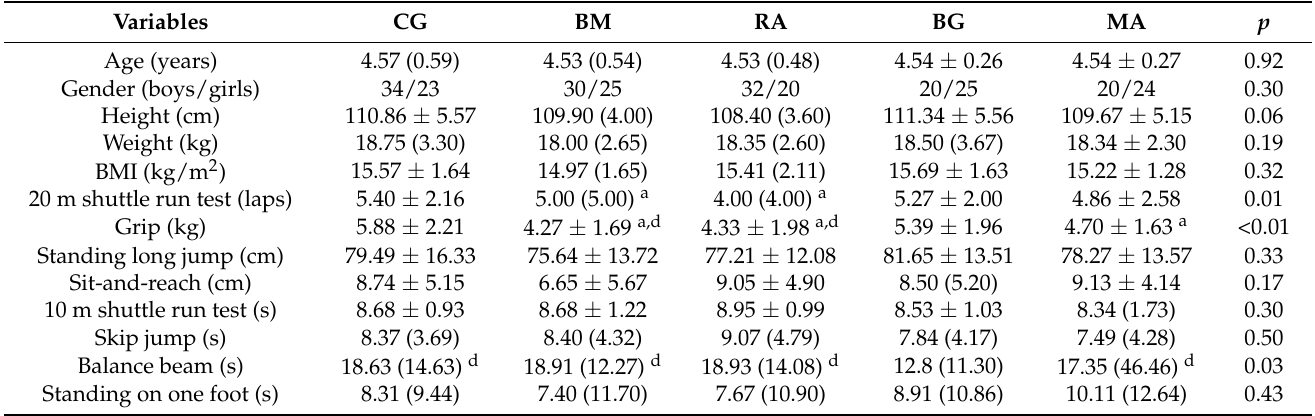
Table 1. Participant characteristics and Physical Fitness Test before each